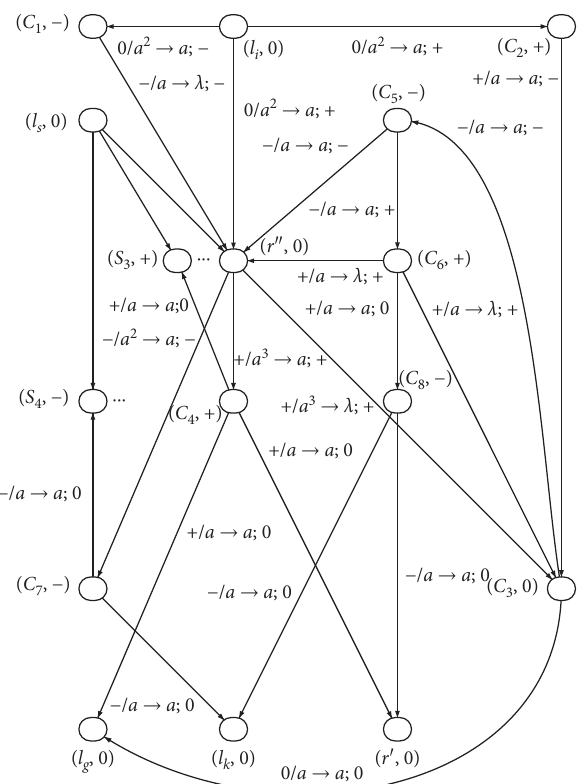
Figure 12: The module simulating consecutive SUB-ADD